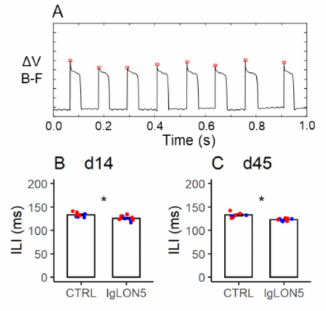
Figure 7. Panel ( A ) shows representative raw tracings of licking behavior in a female hTau mouse upon termination of the 14-day period of intracerebroventricular infusion with antibodies from a patient with anti-IgLON5 disease. ∆ V ( B – F ): electric potential difference between the steel nozzle of the water bottle and an aluminum plate on the cage floor beneath the mouse. Upward deflections of ∆ V ( B – F ) correspond to individual licks. The inter-lick intervals (ILI) are measured as the time intervals between the peaks of ∆ V ( B – F ) deflections (red squares). ( B , C ): values of ILI at the end of the 14-day infusion (d14) and ≥ 1 month afterward (d45) in female wild-type (blue) and hTau (red) mice infused with antibodies from patients with anti-IgLON5 disease (IgLON5) or from control (CTRL) subjects. Bars show means ± SEM. Dots show values in individual mice. * p < 0.05, ANOVA main effect of IgLON5 vs. CTRL antibodies. Detailed statistical results are reported in Table